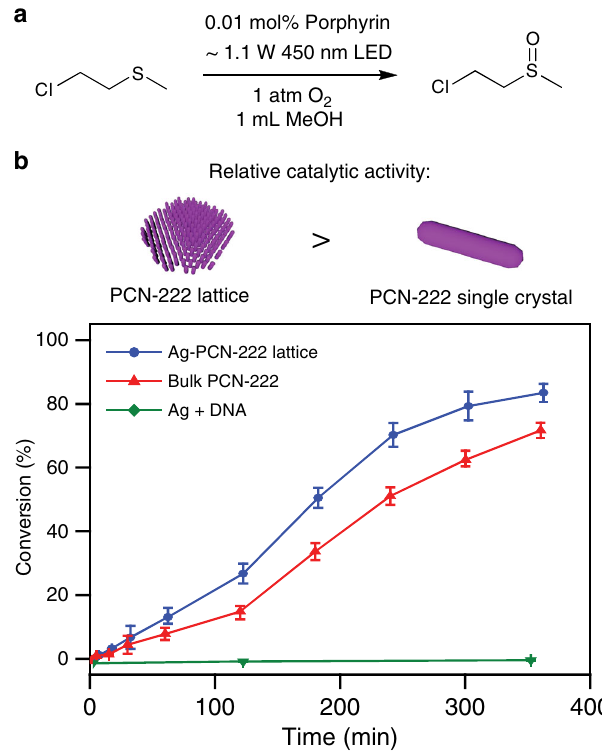
Fig. 5 Photocatalytic activity of the 2D PCN-222 nanorod superlattices. a Reaction pathway for the oxidation of the mustard gas simulant CEES, using oxygen and a porphyrin photosensitizer. b Reaction pro fi les for the oxidation of CEES using a Ag + -stabilized PCN-222 superlattice (blue) and a PCN-222 single crystal (red), respectively (same porphyrin loading). All samples were irradiated with blue light-emitting diodes (LEDs, wavelength max = 450 nm) with equivalent power density. No appreciable catalytic activity was observed for the Ag + ion and single-strand DNA control group (green). The error bars display the standard deviation of measurements for three separately prepared